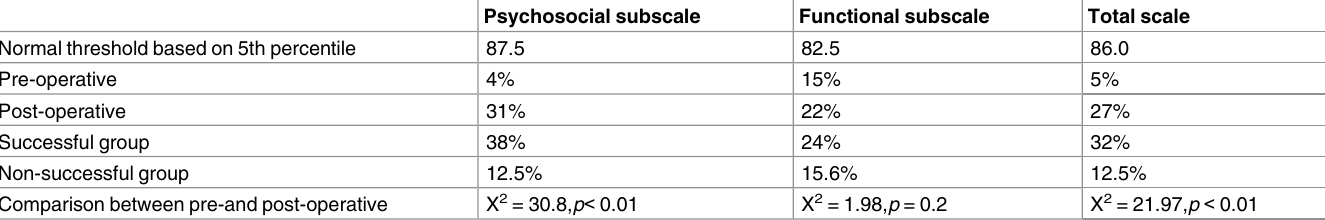
Table 2. Percent scoring within the normal threshold before and after surgery.